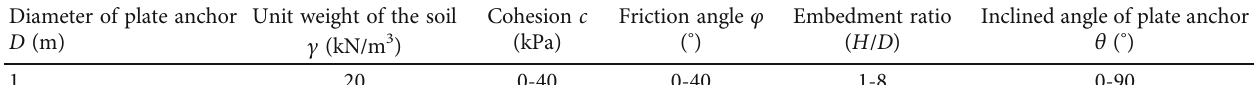
Table 1: Properties of numerical model.